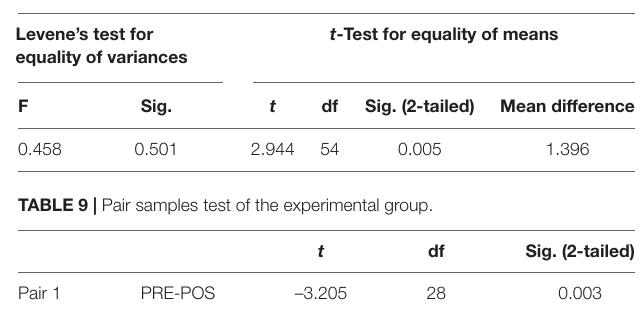
TABLE 8 | Independent t -test of post-test results.